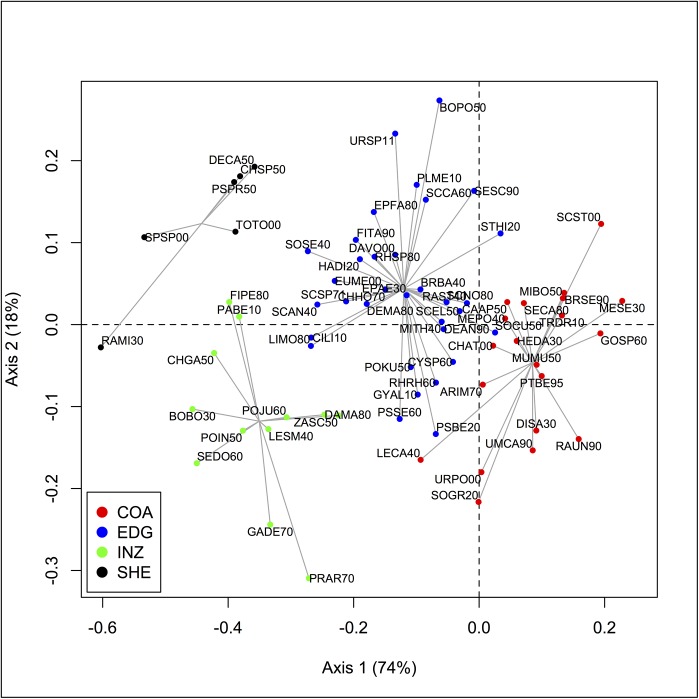
Projections of groundfish species variables and assemblage groups projected on the compromise space.The first factor plane (axes 1 and 2) with the main assemblage species obtained by hierarchical cluster analysis (UPGMA, see the methods section): coastal (COA), intermediate (INZ), shelf edge (EDG) and deeper assemblages (SHE).